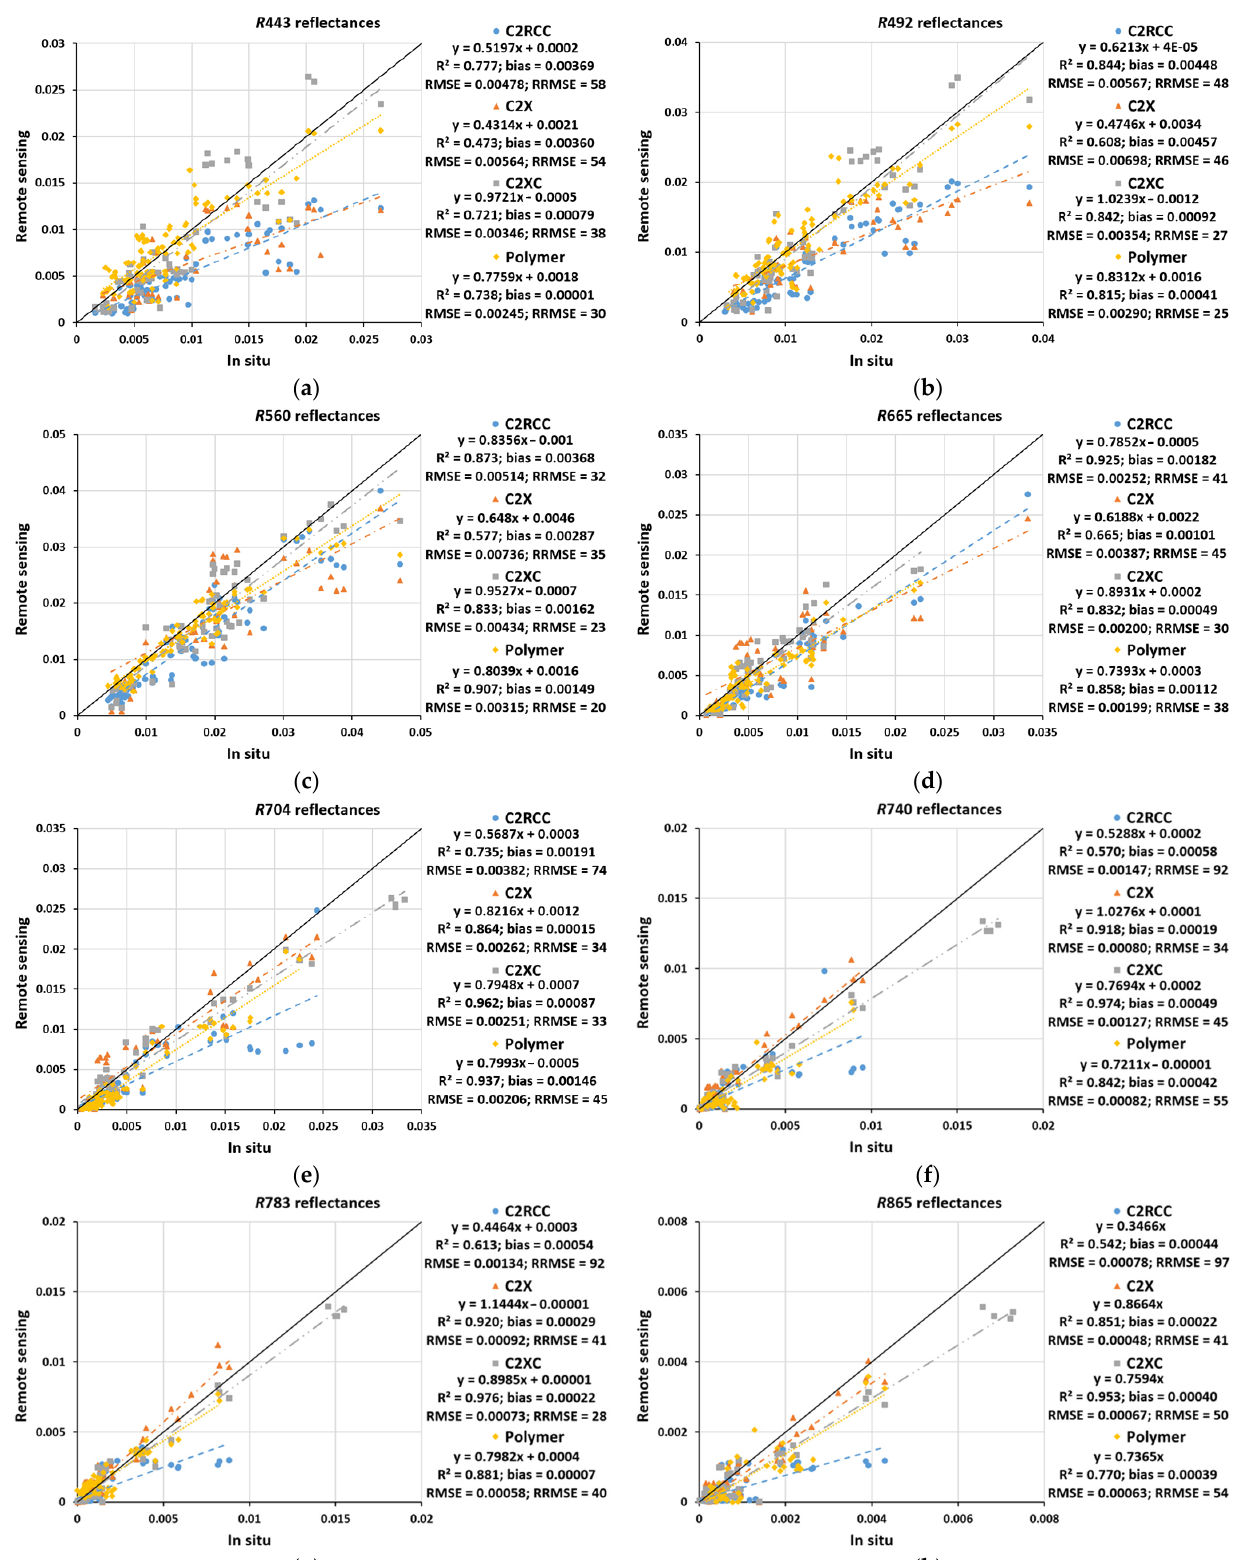
Figure 3. Linear correlations between the in situ and remote sensing reflectance data for the different S2-MSI bands and respective validation statistics results, using 81 samples for C2RCC, 41 for C2X, 55 for C2XC, and 92 for Polymer. RMSE and bias in sr − 1 and RRMSE in